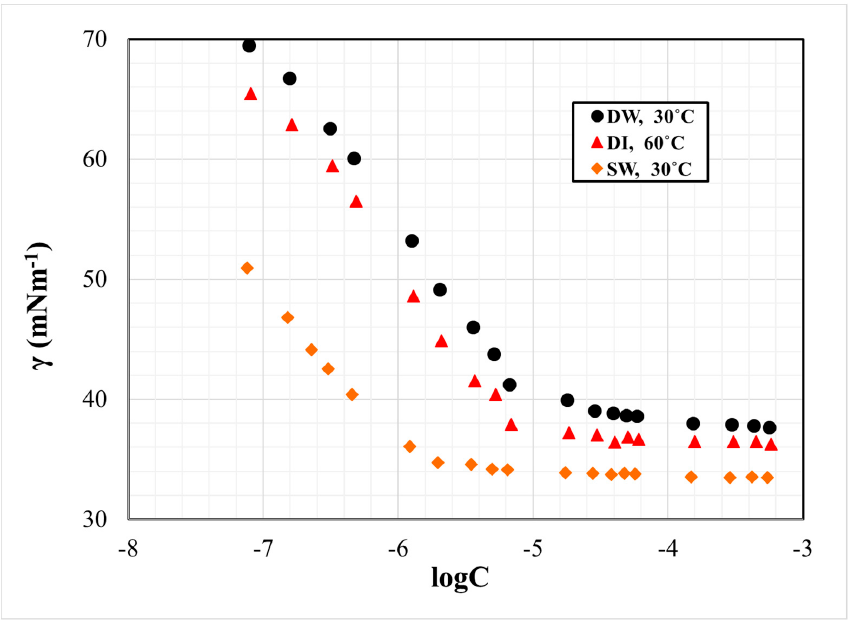
Figure 13. The surface tension of GS10 at different salinities and temperatures.